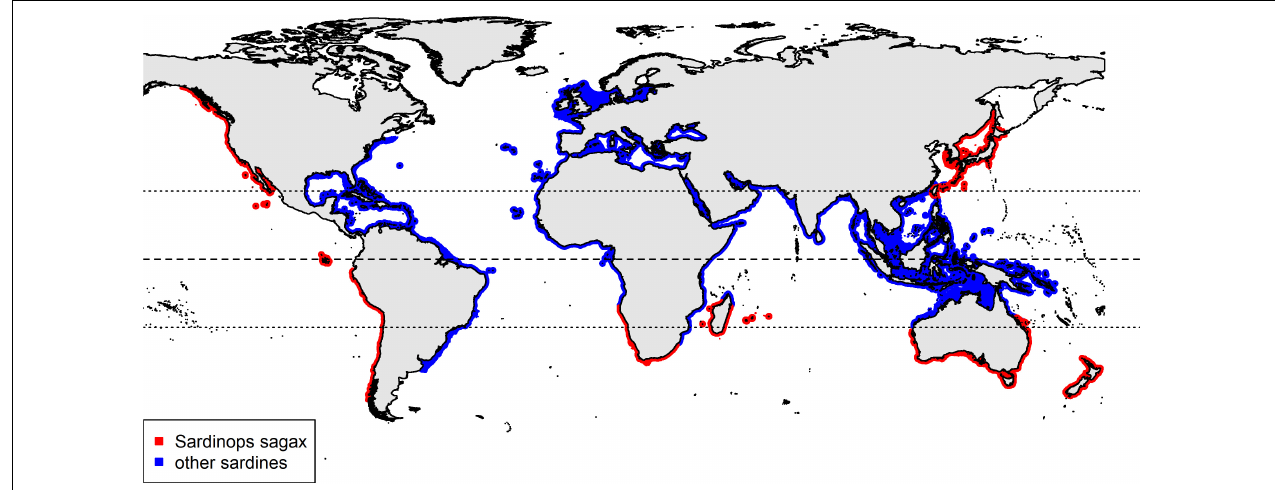
FIGURE 1 | A global distribution of sardines highlighting the range for Sardinops sagax (data sourced from Nature Serve and IUCN,